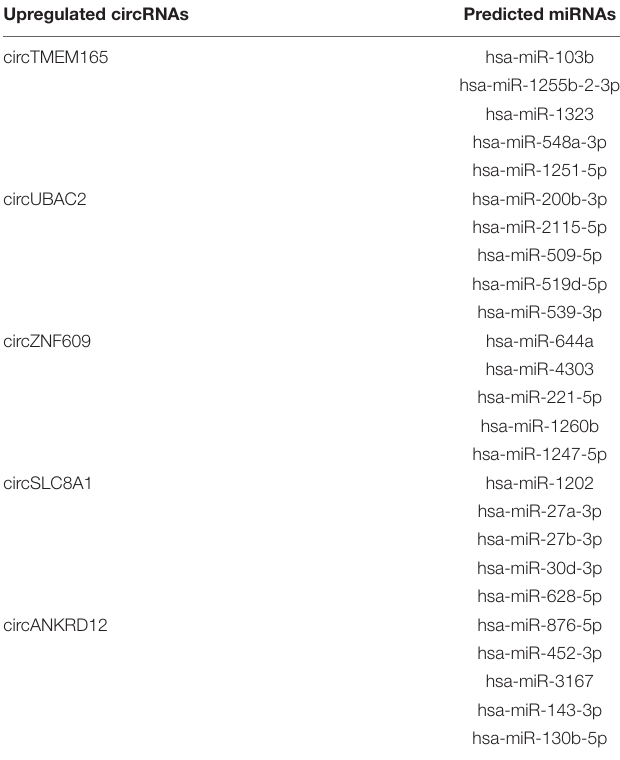
TABLE 3 | The predicted miRNAs related to circRNAs. Upregulated circRNAs Predicted